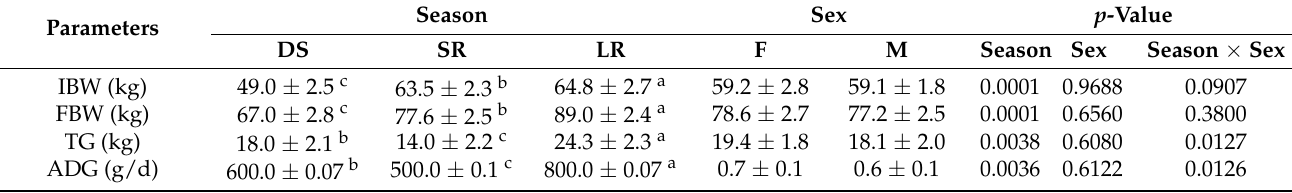
Table 6. Bodyweight of Fogera cattle calves under different seasons (mean ±